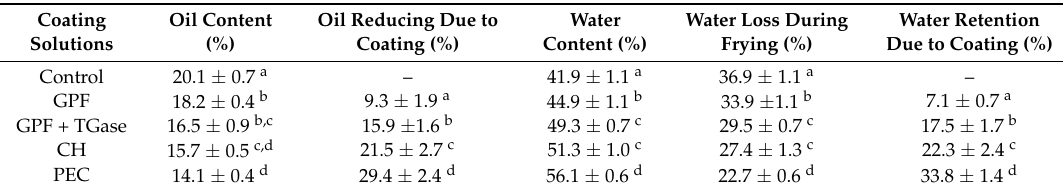
Table 2. Effect of hydrocolloid coatings on the quality of potato French fries. Samples were coated with different hydrocolloid-based coatings made of GPF, grass pea flour; GPF + TGase, grass pea flour treated by transglutaminase; CH, chitosan; and PEC, pectin. “Uncoated” represents the control sample dipped in distilled water *.